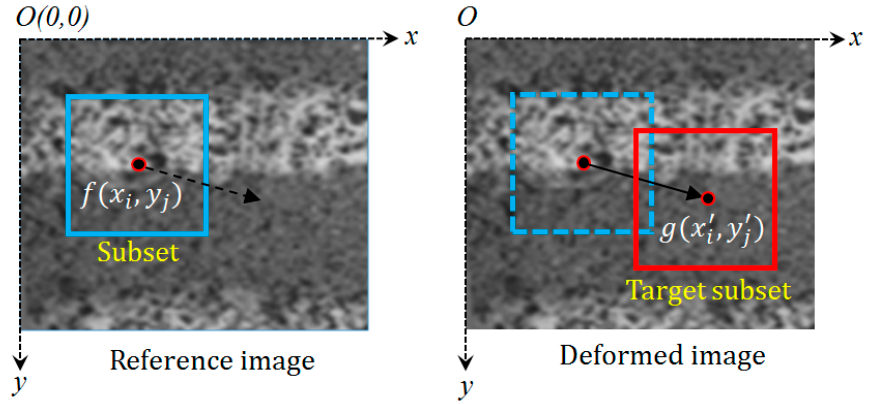
Figure 1. The principle of measuring the displacement by using the digital image correlation method.